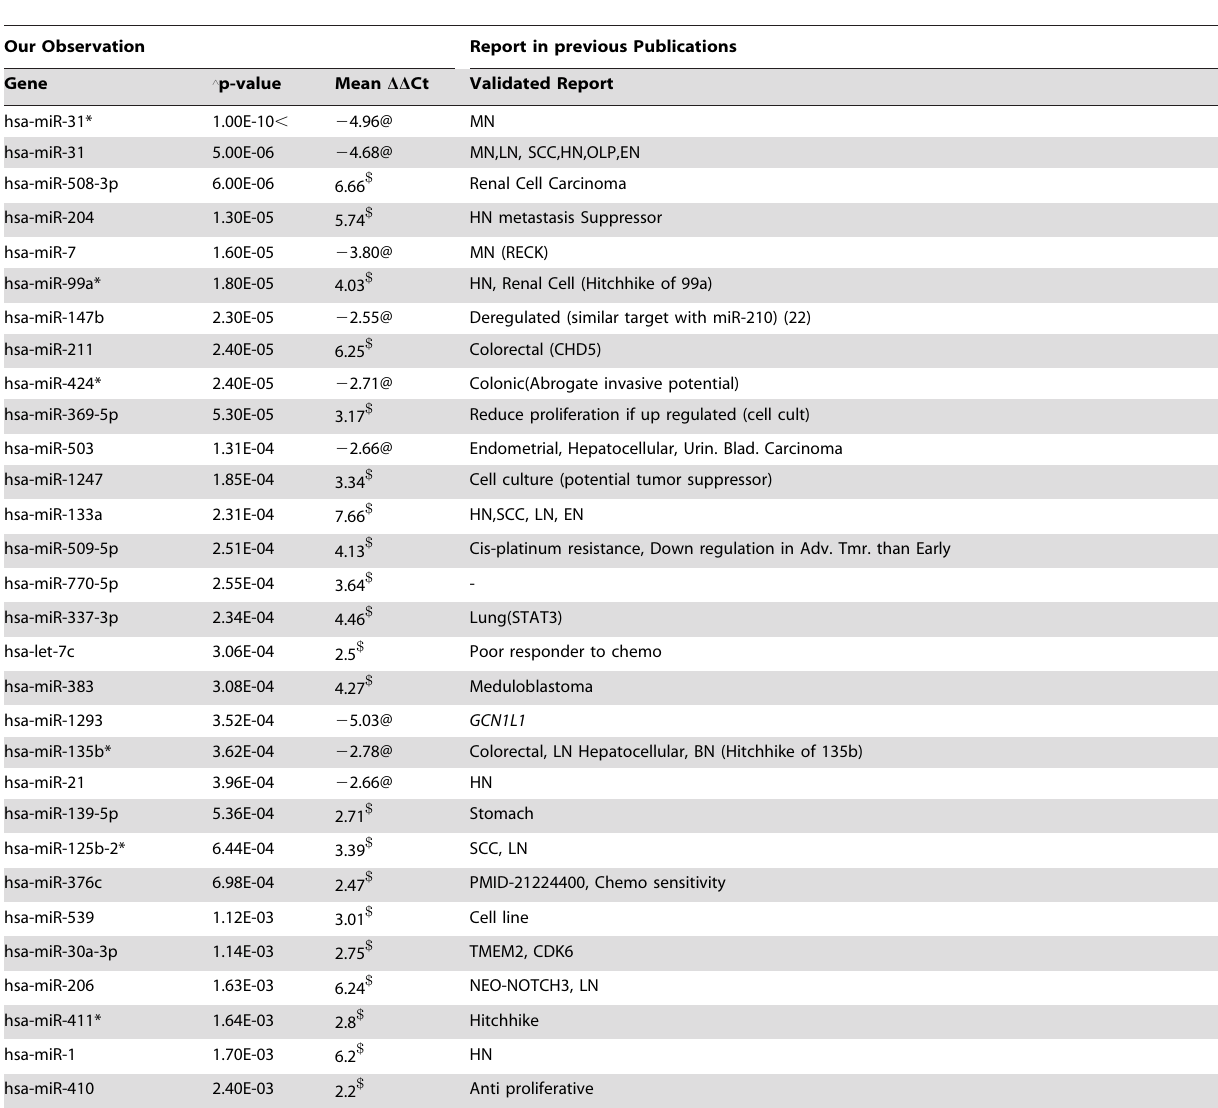
Table 6. Relevant literature search for diseases by 30 significantly deregulated miRNAs in cluster of 13 samples.